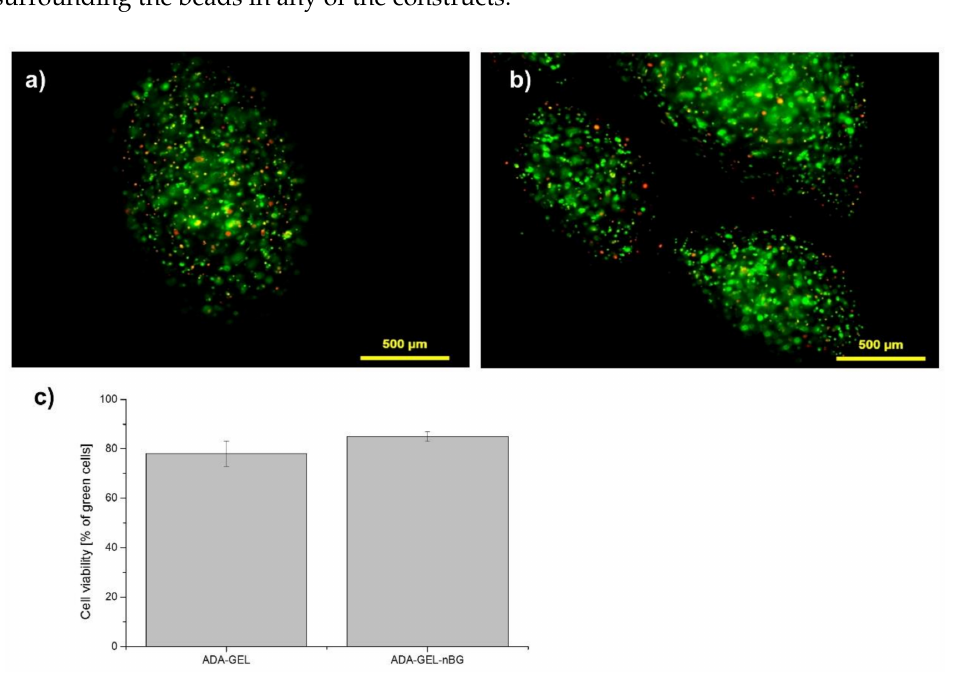
Figure 1. Fluorescence microscopy images of rat bone marrow derived mesenchymal stem cells (rMSCs) cells encapsulated in alginate dialdehyde-gelatin (ADA-GEL) ( a ) and ADA-GEL-nano-scaled bioactive glass (nBG), ( b ) after encapsulation ( a , b : green—calcein-stained live cells in images, red—PI-stained dead cells; cells were incubated for 7 days before live-dead staining was performed). Quantitative